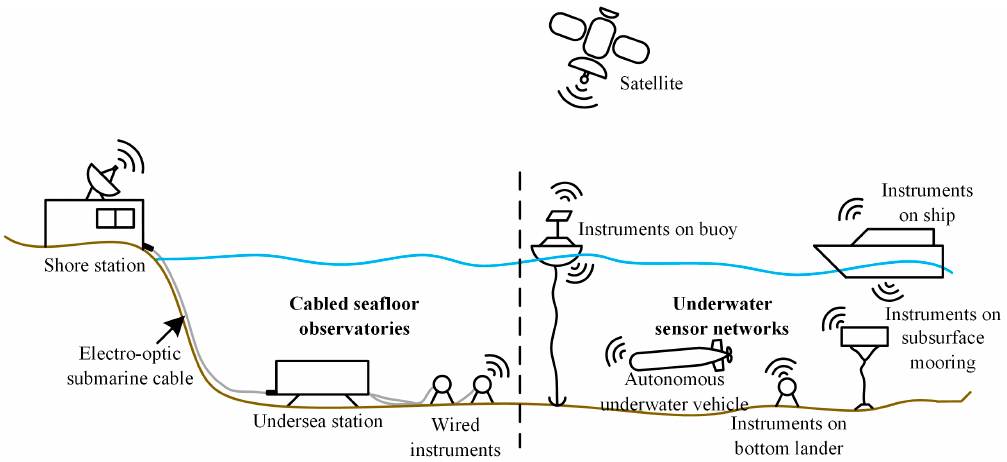
Figure 1. Two typical systems of scientific ocean observatories.